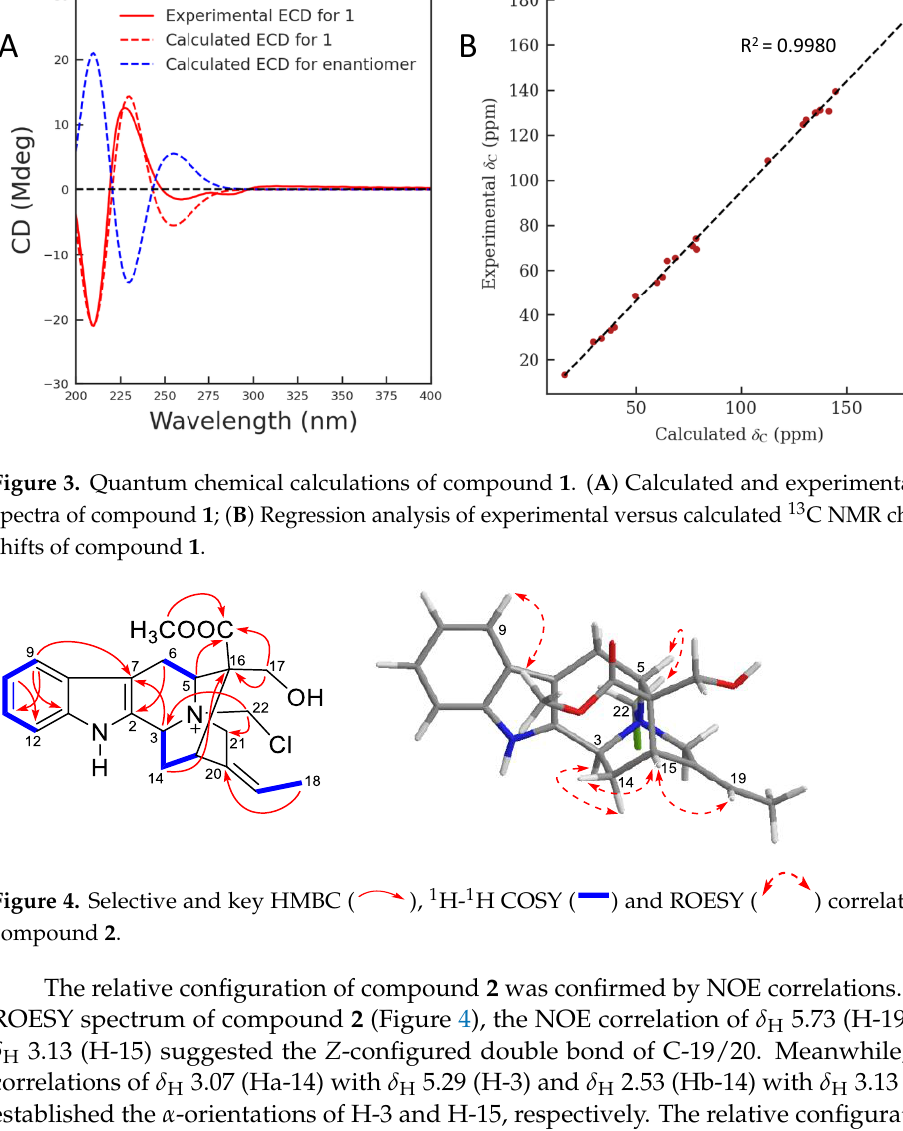
Figure 1. Structures of compounds 1 – 2 .